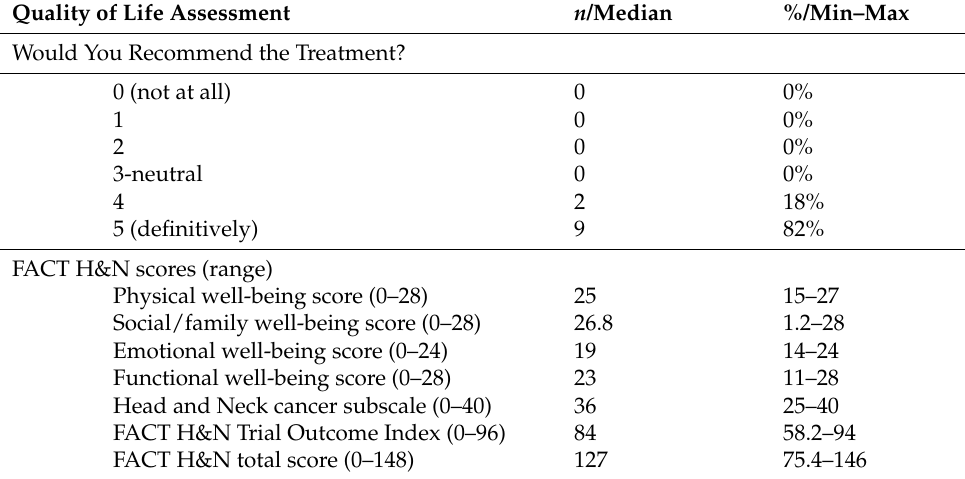
Table 4. Quality of life assessment ( n =